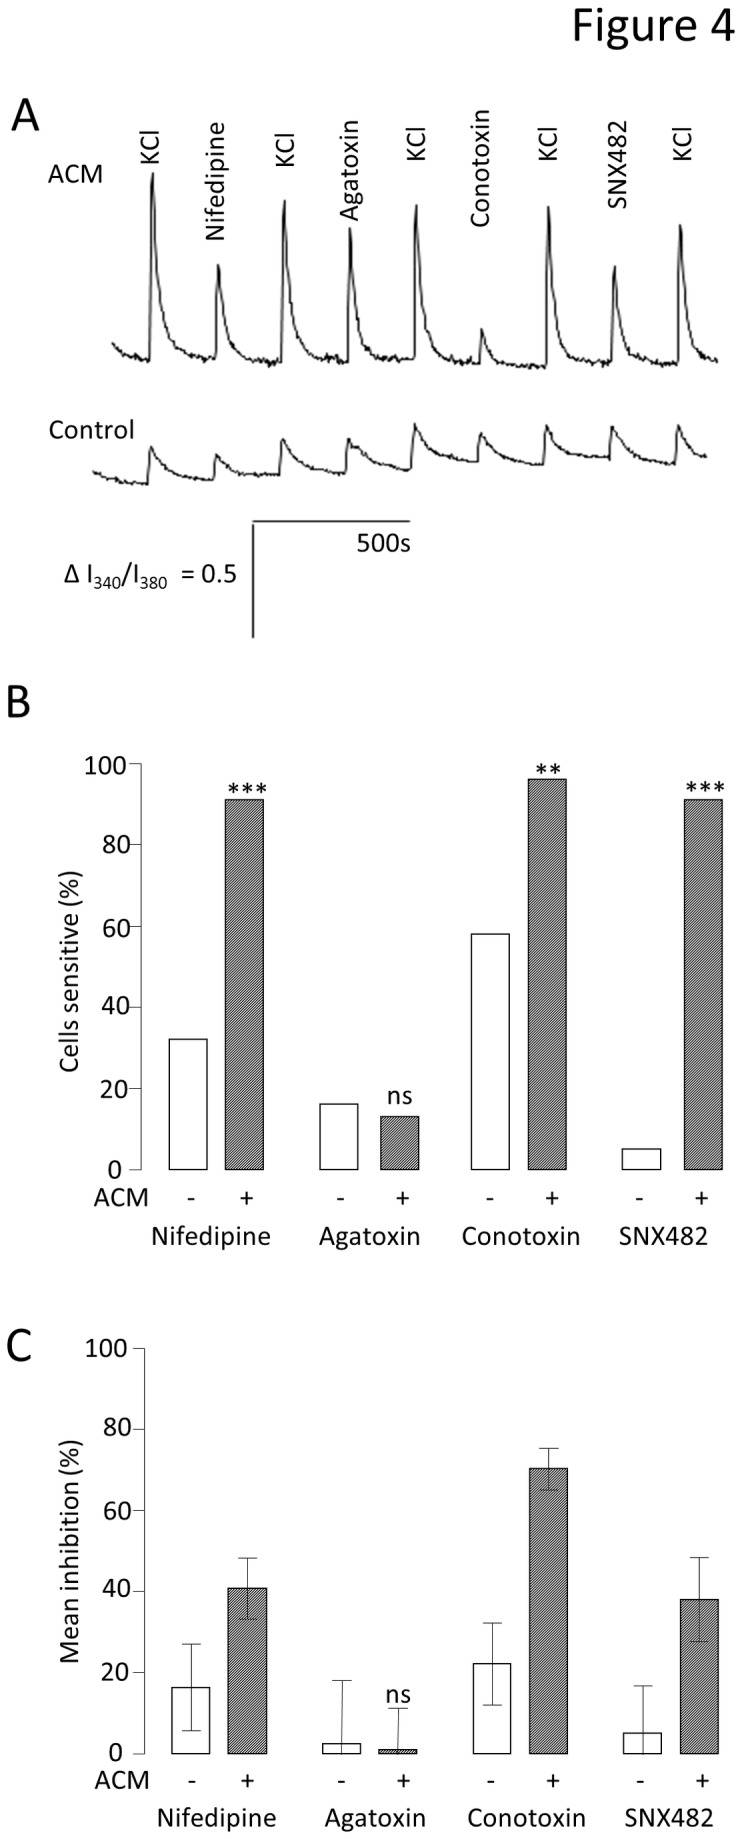
Effect of ACM on functional expression of voltage-activated Ca2+ channels.A. Mean traces of the ratio of intensity (I340/I380) from fura-2 Ca2+ imaging for control medium (solid line) and ACM-treated (dashed line) cells at week 1. Ca2+ influx was evoked using 50mM K+ solution (High K+) to depolarise the neurons. To measure the influence of different sub-types of voltage activated Ca2+channel on the depolarisation-evoked peak as a whole (the sum of the voltage activated Ca2+ influx) antagonists of specific channels were added to the High K+ solution: 10µM nifedipine (L-type Ca2+ channels), 100nM conotoxin (N-type Ca2+ channels), 100nM agatoxin (P/Q- type Ca2+ channels) and 100nM SNX482 (R-type Ca2+ channels).B. Bar graph comparing the proportion (%) of neurons which showed significant (> 5%) inhibition by each antagonist for control medium- and ACM-treated cells at week 1, compared by chi2 tests. ***P < 0.001, **P < 0.01, nsnot significant; n = 42.C. Bar graph showing the reduction of Ca2+ influx (mean % inhibition) elicited by each antagonist for control medium- and ACM-treated cells at week 1, compared by t-tests. ***P < 0.001, **P < 0.01, nsnot significant; n = 42.